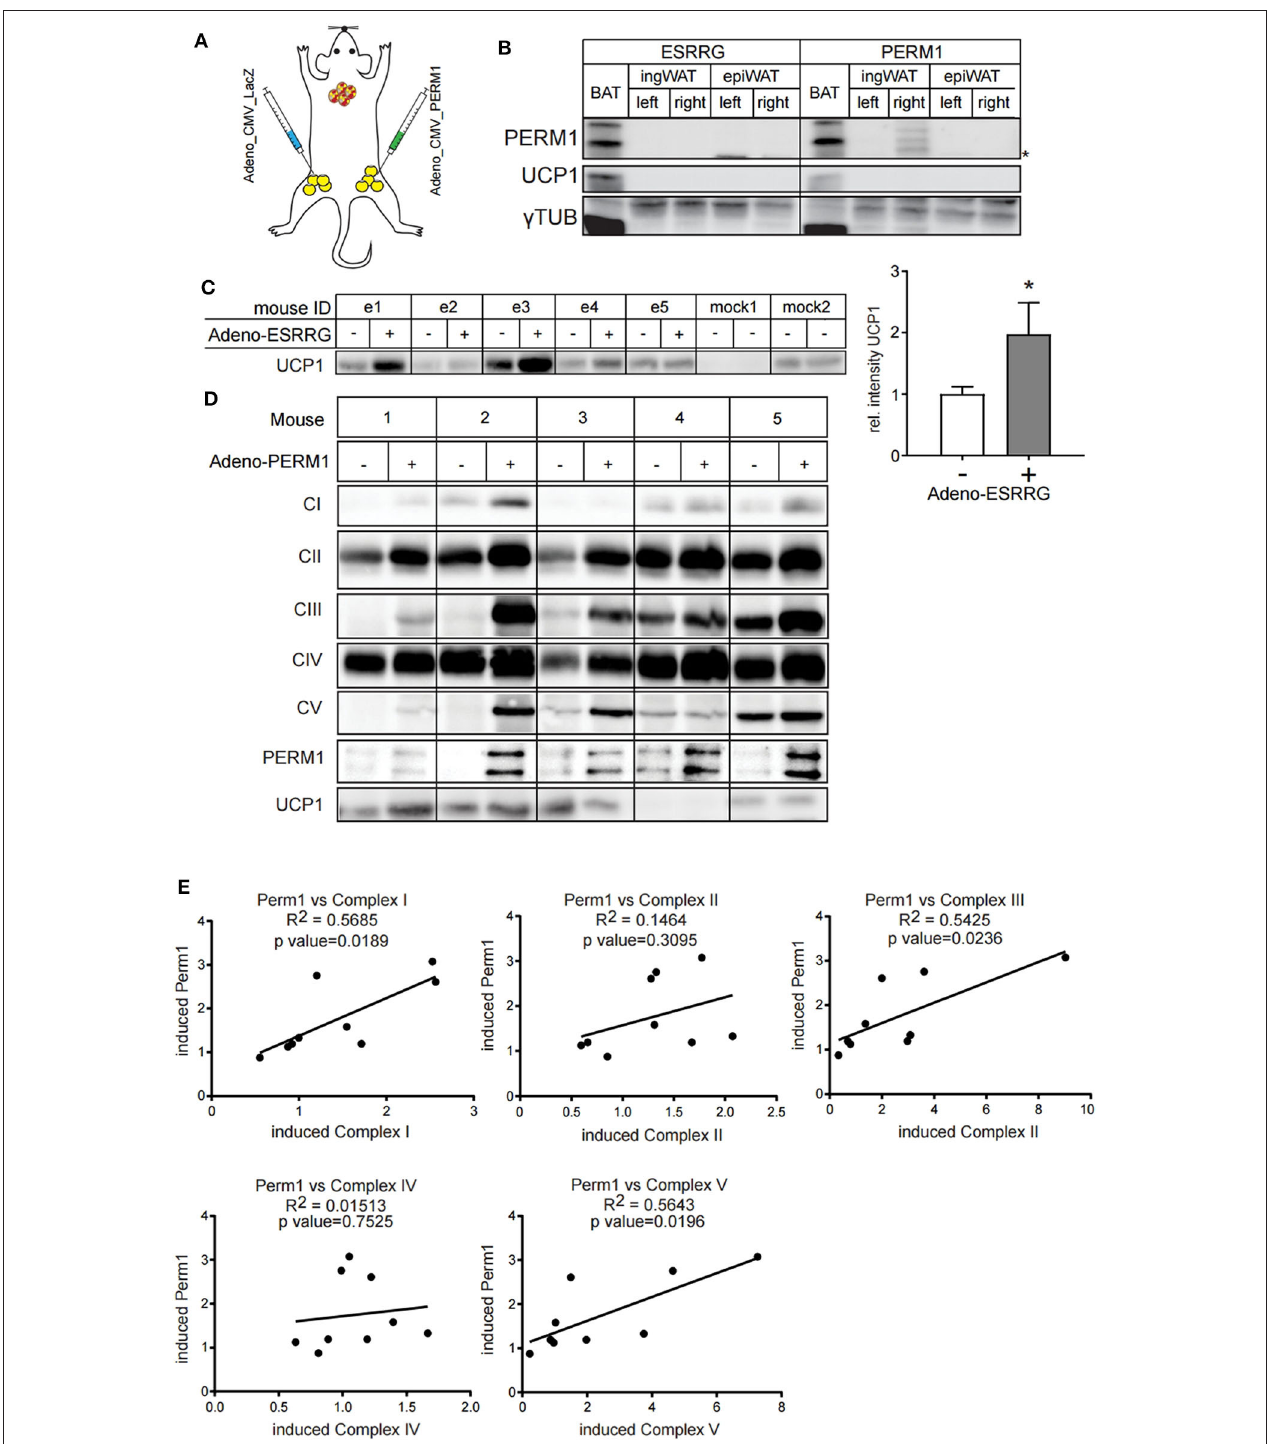
FIGURE 6 | ESRRG and PERM1 positively regulate browning of ingWAT in vivo . (A) Schematic illustration of the direct injection of adenoviral particles leading to the overexpression of LacZ (left ingWA fat pad) and PERM1 (right ingWA fat pad) in the same mouse. (B) PERM1 detection in the ingWA fat pad injected with the adenoviral particles for PERM1 overexpression. (C) Representative western blot and quantification of UCP1 in the ingWA fat pad injected with adenoviral particles for ESRRG overexpression ( + ). (D) Representative blots for OXPHOS complex subunits, UCP1 and PERM1 expression in ingWA fat pad injected with the adenoviral particles of PERM1 overexpression. (E) Correlation of PERM1 expression with different OXPHOS subunits as shown by protein expression in nine mice injected in one ingWA fat pad with adenoviral particles for PERM1 overexpression. A statistically significant result, meaning p -value < 0.05, is indicated with an asterisk (*).